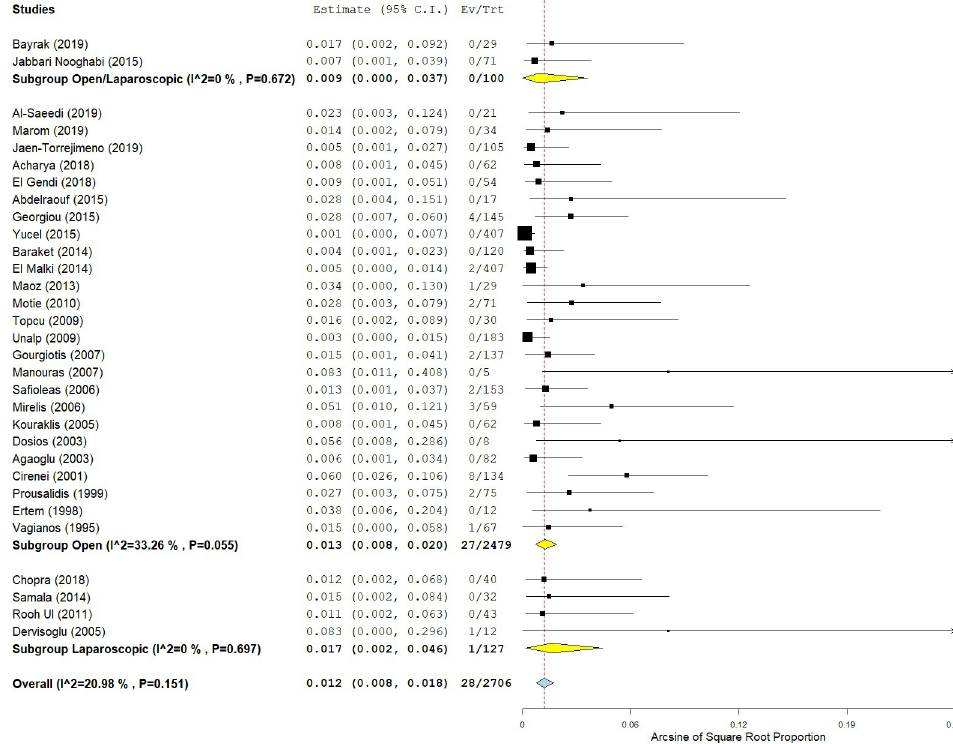
Fig 4. Forest plot of the mortality rate after endocystectomy for cystic echinococcosis, with subgroup analysis of laparoscopic and open surgeries.